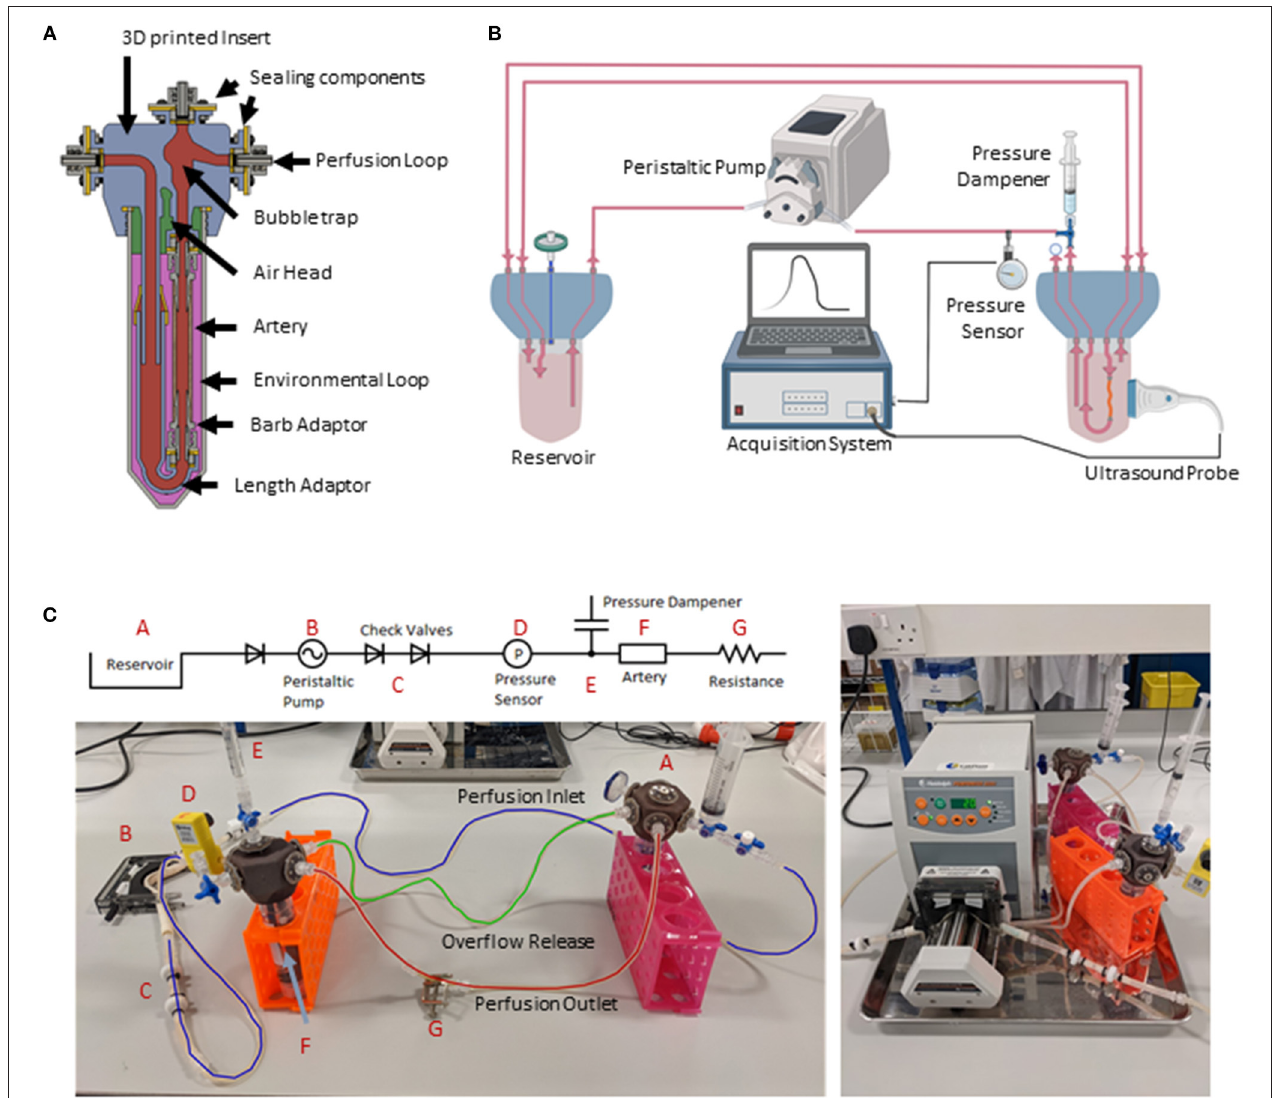
FIGURE 1 | EasyFlow system characteristics and setup. Cross-sectional view of the EasyFlow insert visualizing the inner structure and interconnectivity of the reaction space contained within a 50ml centrifuge tube (A) . Schematic of the perfusion loop which includes the EasyFlow bioreactor accommodating the porcine carotid artery, a reservoir, the peristaltic pump, and acquisition system (B) . A simplified connection map and true image of system identifying the key elements of the perfusion loop (C)